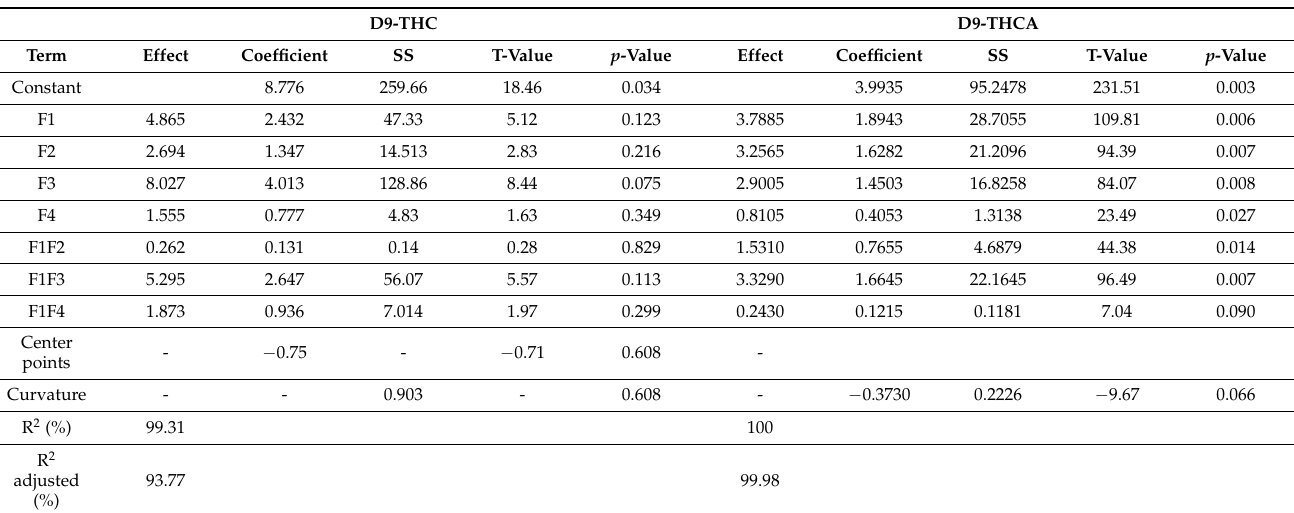
Table 7. Estimated coefficient and effects for delta 9-tetrahydrocannabinol (D9-THC) and